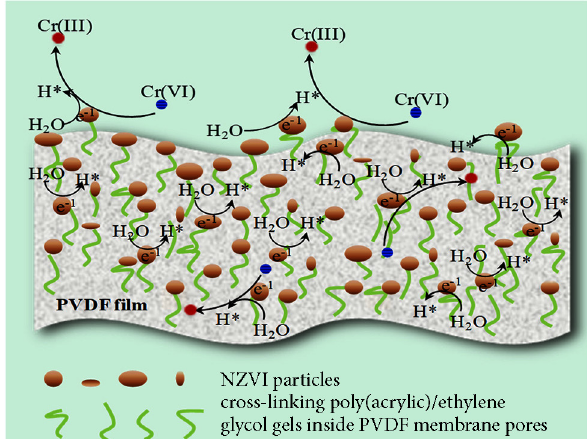
Cr(VI) removal with different materials (PP, PPN and